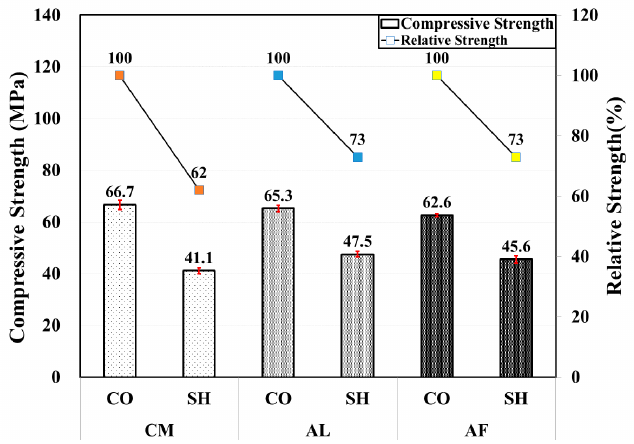
Figure 7. Compressive and relative strength by accelerators for 24-month-old specimens.